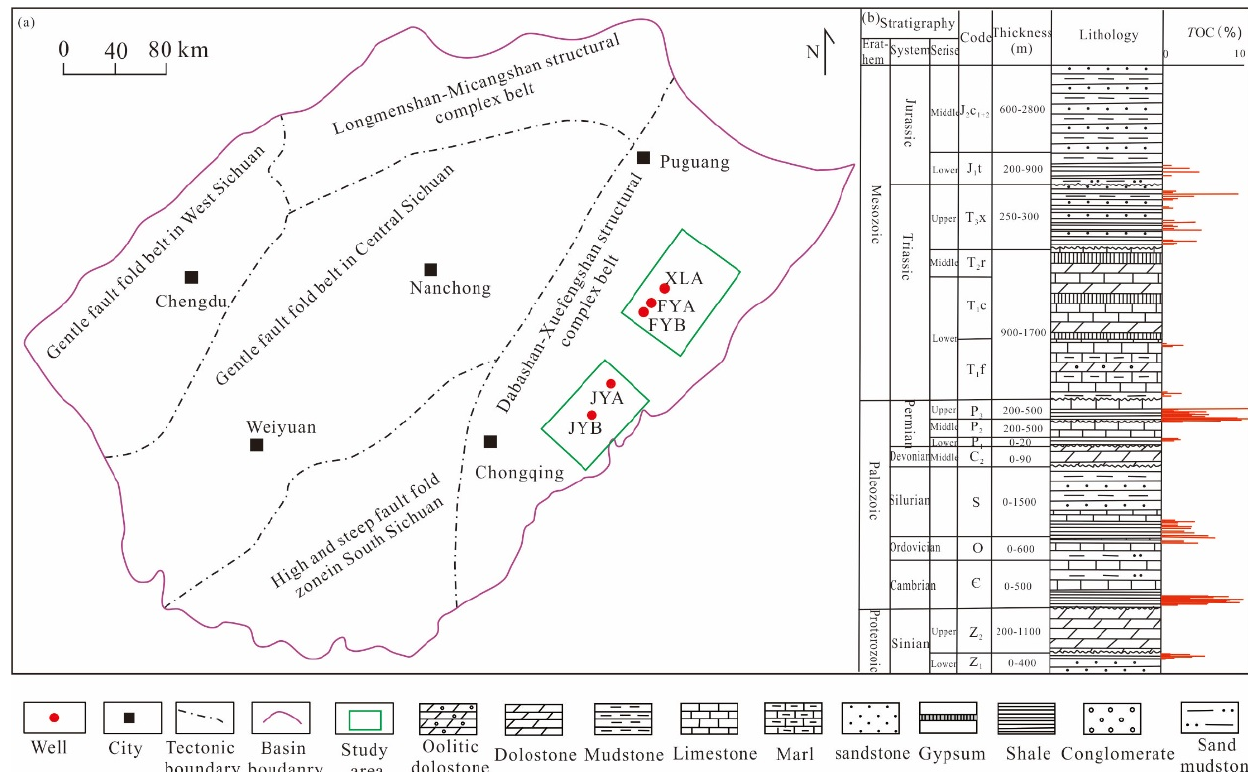
Figure 1. Structural units ( a ) and generalized stratigraphic column ( b ) of the Sichuan Basin, West China; ( b ) was modified from [35].